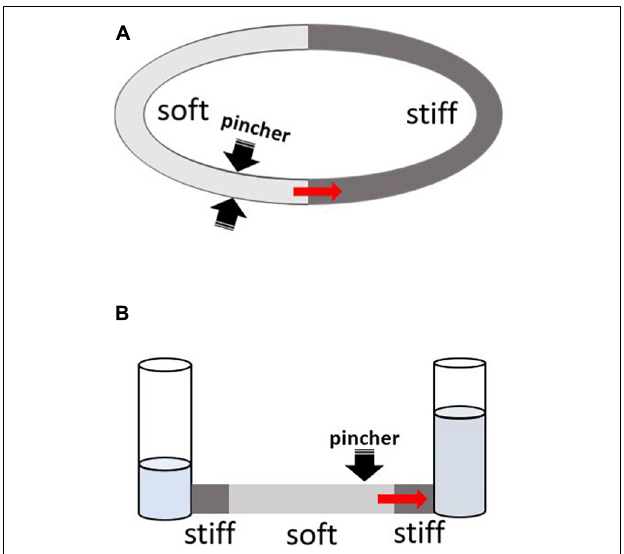
FIGURE 1 | Two main configurations for testing Liebau-based pumping. The red arrow depicts the direction of mean flow as originally reported by G. Liebau from pincher toward the nearest junction with stiff tubing. Depending on the compression frequency, the flow can also occur in an opposite direction. (A) Two tubes with different compliances are connected to form a close loop conduit. Pincher is typically a rectangular piston being pushed into soft tubing (light gray) by some form of linear actuator. When the asymmetrically positioned pincher is periodically compressed, it creates pulsative flow. (B) The compliant segment is depicted in light gray. On both ends, it connects to stiff tubes that are attached to open tanks filled with fluid. Pincher is an asymmetrically positioned piston that compresses the soft segment with a defined